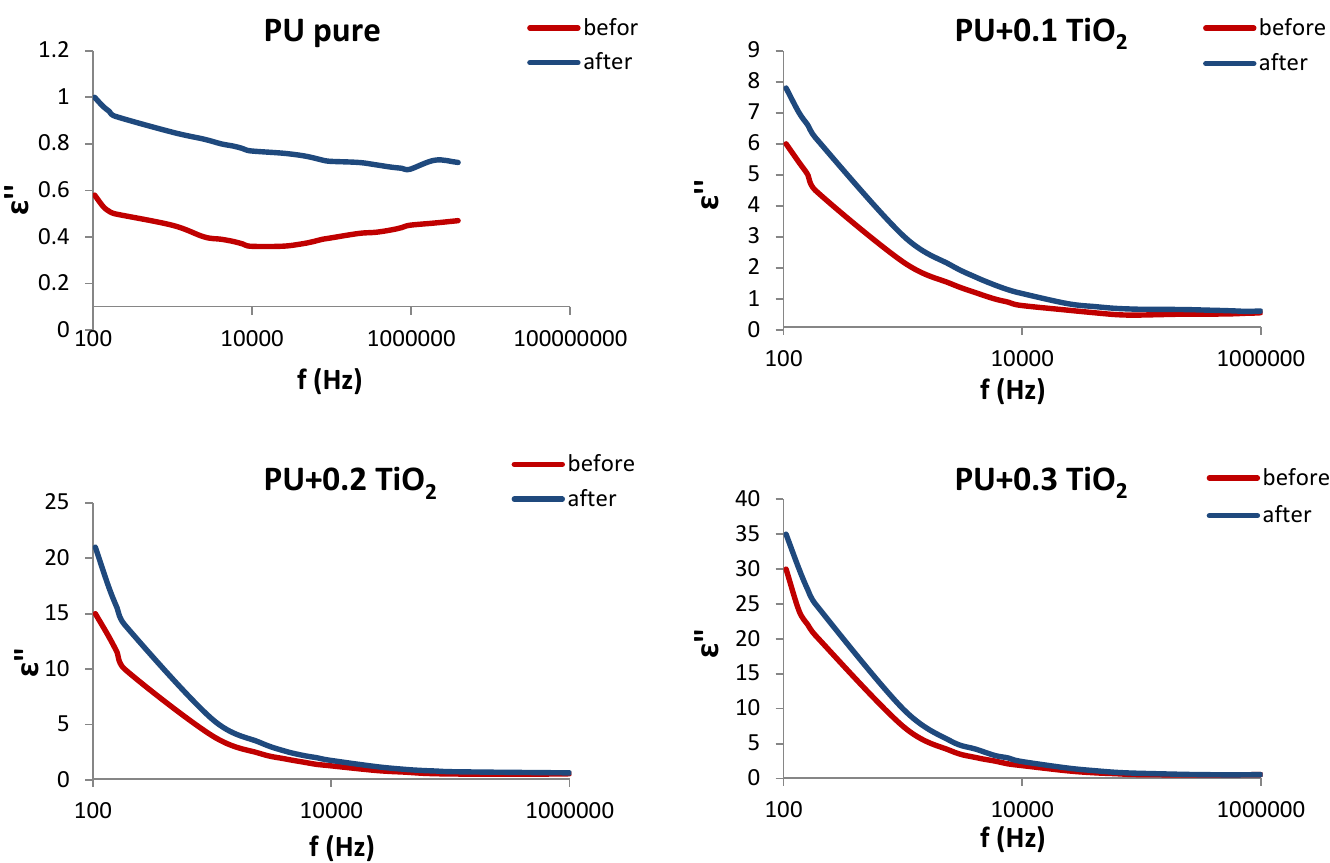
Fig. 5: Variation of dielectric loss as a function of frequency before and after UV irradiation for PU and (PU-TiO ) composite. 2